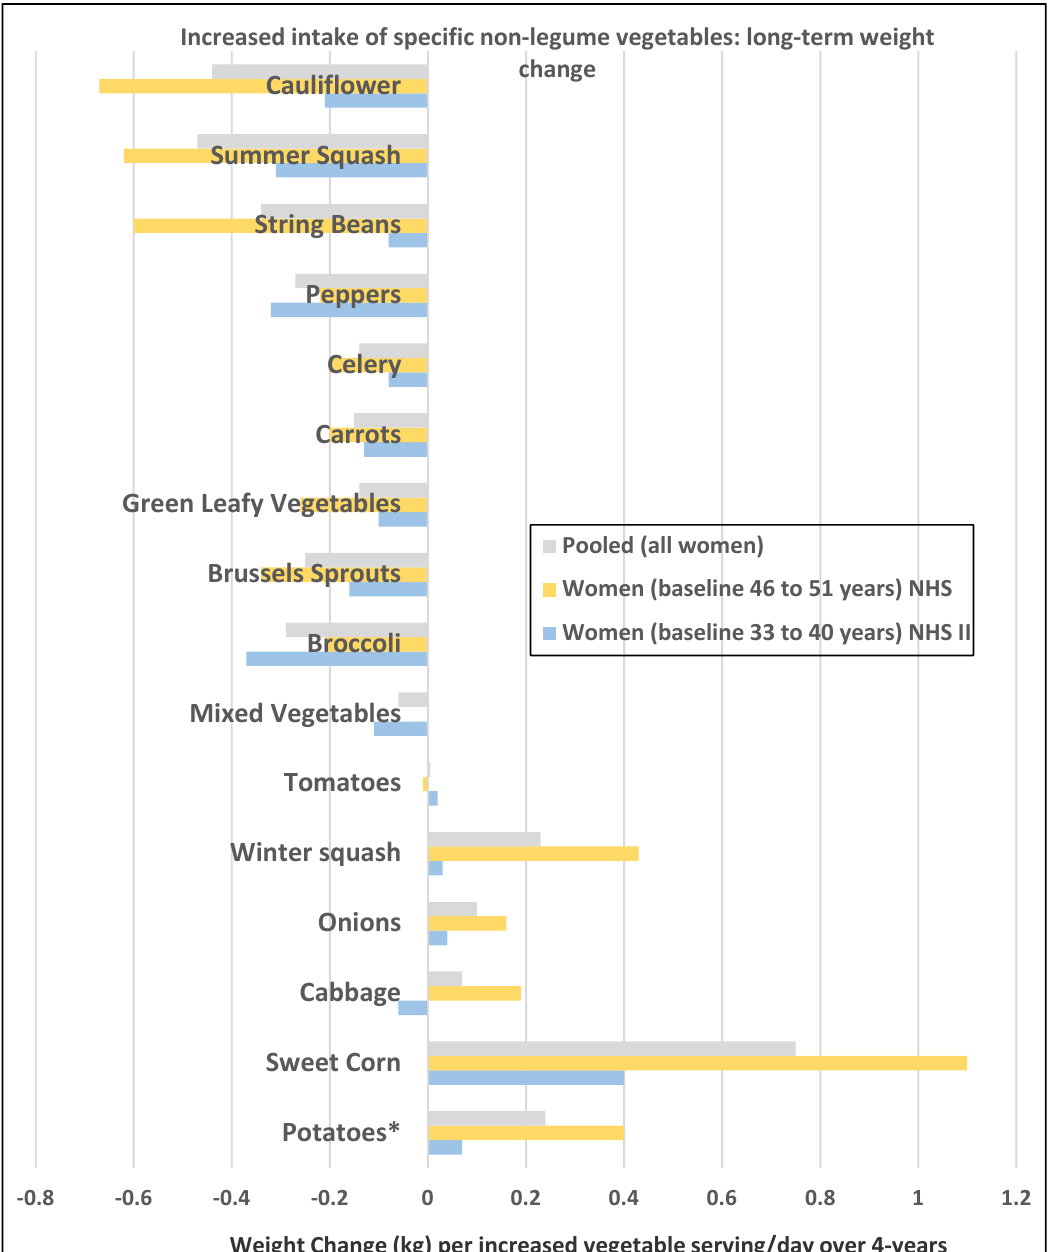
Figure 2. Multivariate adjusted associations from the Nurses’ Health Studies (NHS) per increased serving/day of specific non-legume vegetables and 4-year weight change (kg) in women of different age groups (e.g., premenopausal vs. postmenopausal) [18]. * Includes baked, boiled, and mashed white potatoes, sweet potatoes, and yams but excludes French fries and potato chips.